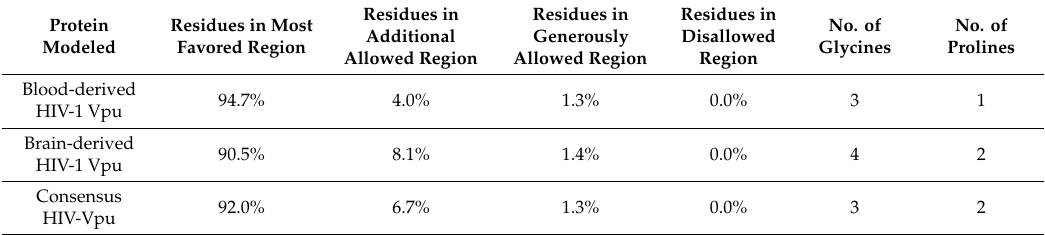
Table 3. Ramachandran plot statistics of blood- and brain-derived modeled Vpu structures and modeled consensus Vpu structure presenting overall model